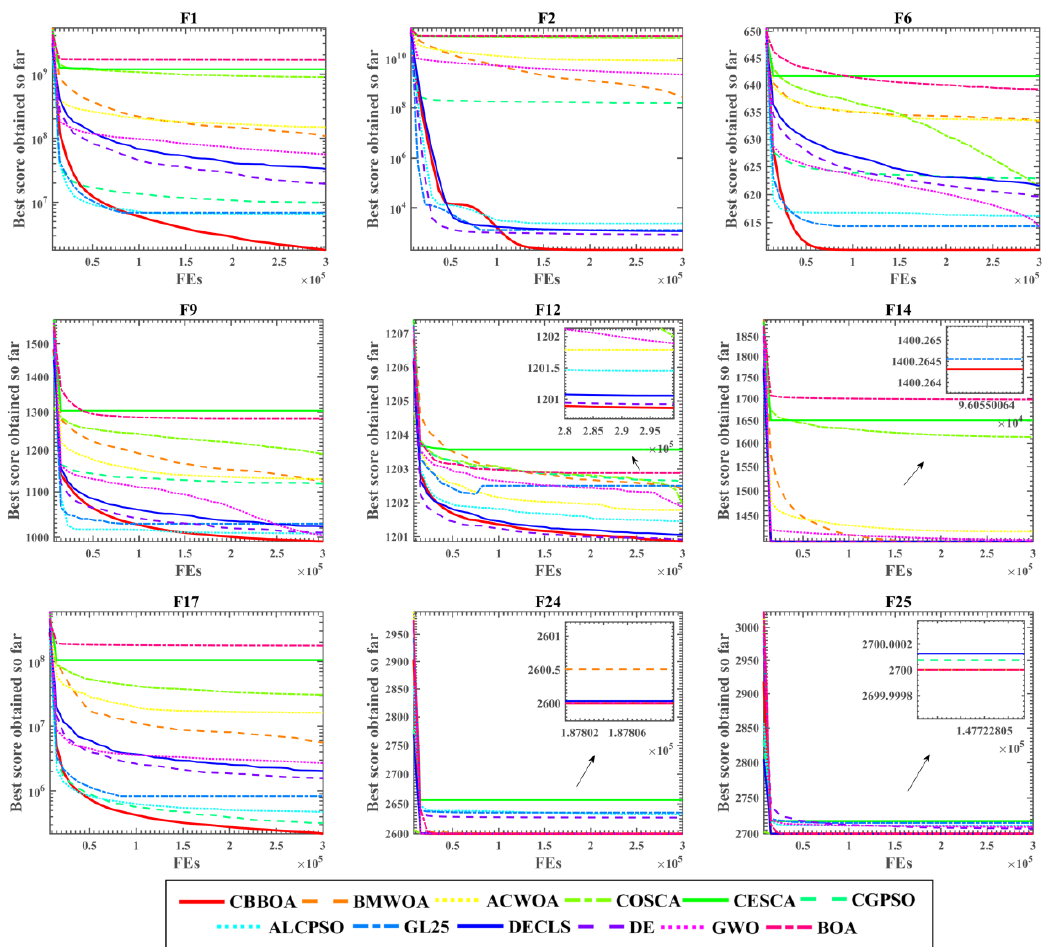
Figure 3. Convergence curves of the CBBOA and advanced algorithms (First row: F1, F2, F6; second row: F9, F12, F14; third row: F17, F24, F25).